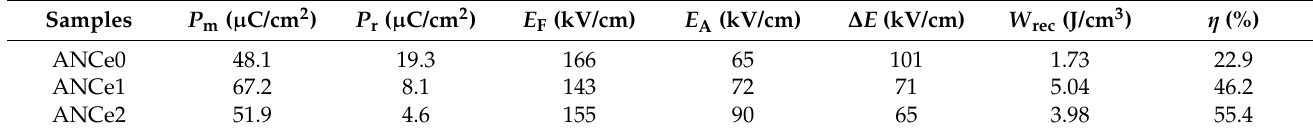
Table 1. Parameters related to energy storage properties of ANCe x